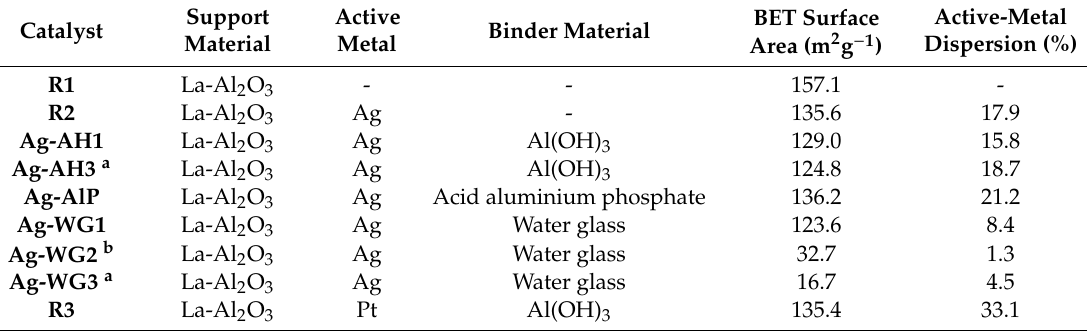
Figure 1. Showing the relationship between the degree of active-metal dispersion and the BET surface area of the catalyst. The blue area highlights the most promising catalysts according to the BET surface area versus dispersion results. For more details about the catalyst, see Table 1. Table 1. Ag and Pt catalysts prepared in this study: binder materials, BET surface areas and levels of active-metal dispersion.